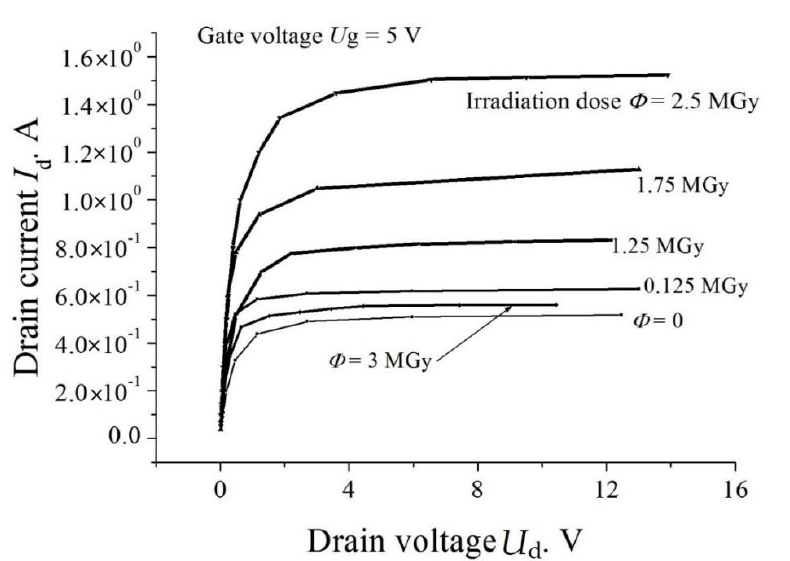
Figure 8. Output characteristics I d (V d ) of a SiC MOSFETs (1.2 kV class) under study at various irradiation doses. The gate voltage V g = 5 V [37].